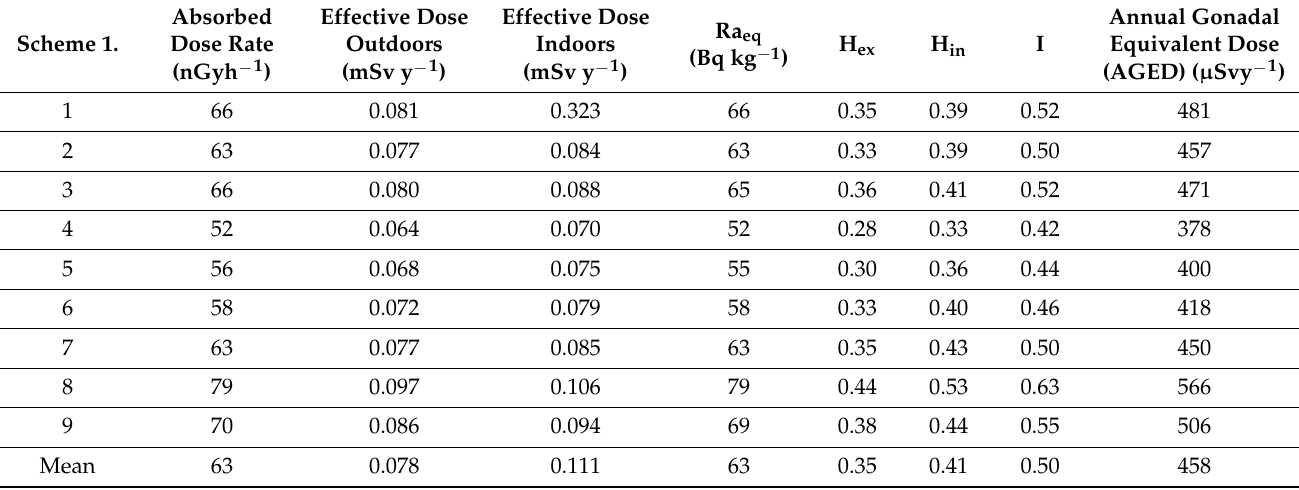
Table 3. Radiological indices in the investigated sampling